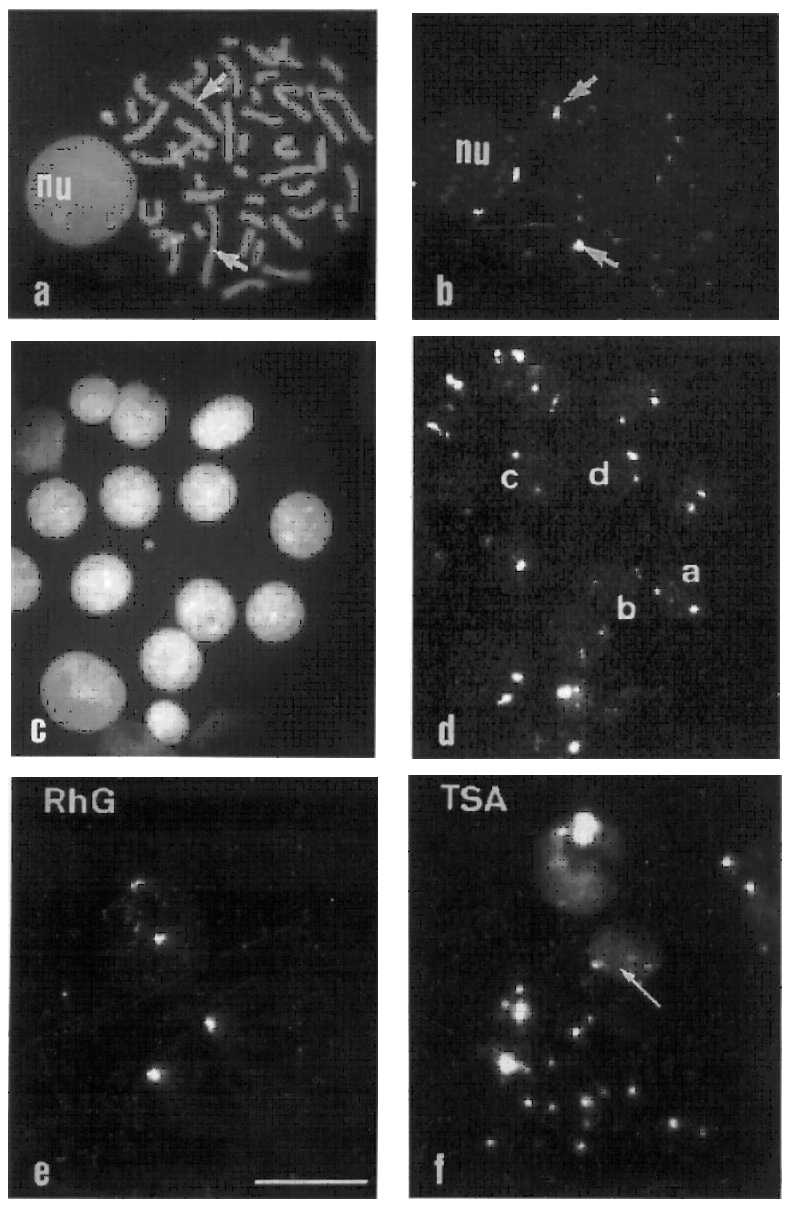
Fig. 1. FISH spots of the centromeric probe for chromosome 3 on metaphases and nuclei of stimulated lymphocytes. (a), (b) Hybridization specificity of the alphoid centromeric probe (arrows). (a) shows a metaphase and a nucleus after DAPI staining with two labeled chromosomes (arrows). (b) shows the principal signals detected with a FITC filter that are located over the two centromeric regions of the chromosome 3 and inside the nucleus. Minor signals are also detected using our high sensitive CCD camera whereas they are not visible when using the DISCOVERY TM system. (c), (d) Hybridization signals of the centromeric alphoid probe for chromosome 3 in interphase nuclei. (c) Field of DAPI-stained nuclei. Figure (d) same field using a FITC filter – many nuclei show two spots. The intensity of the spot fluorescence varies from one nucleus (a) to another (b) as well as inside one nucleus ((c) or (d)). (e), (f) Spot fluorescence using no amplification (e) or with TSA amplification system (f). After TSA, the spot area is very large and the nuclei show strong fluorescence. The heterogeneity of the spots within the same nucleus or between different nuclei is still observed (arrows). Scale bar = 50 (cid:22)